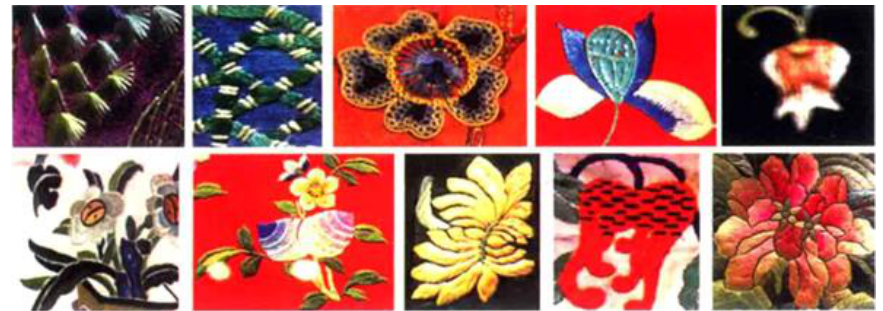
Figure 2. Plant patterns (the picture from Chinese Shu